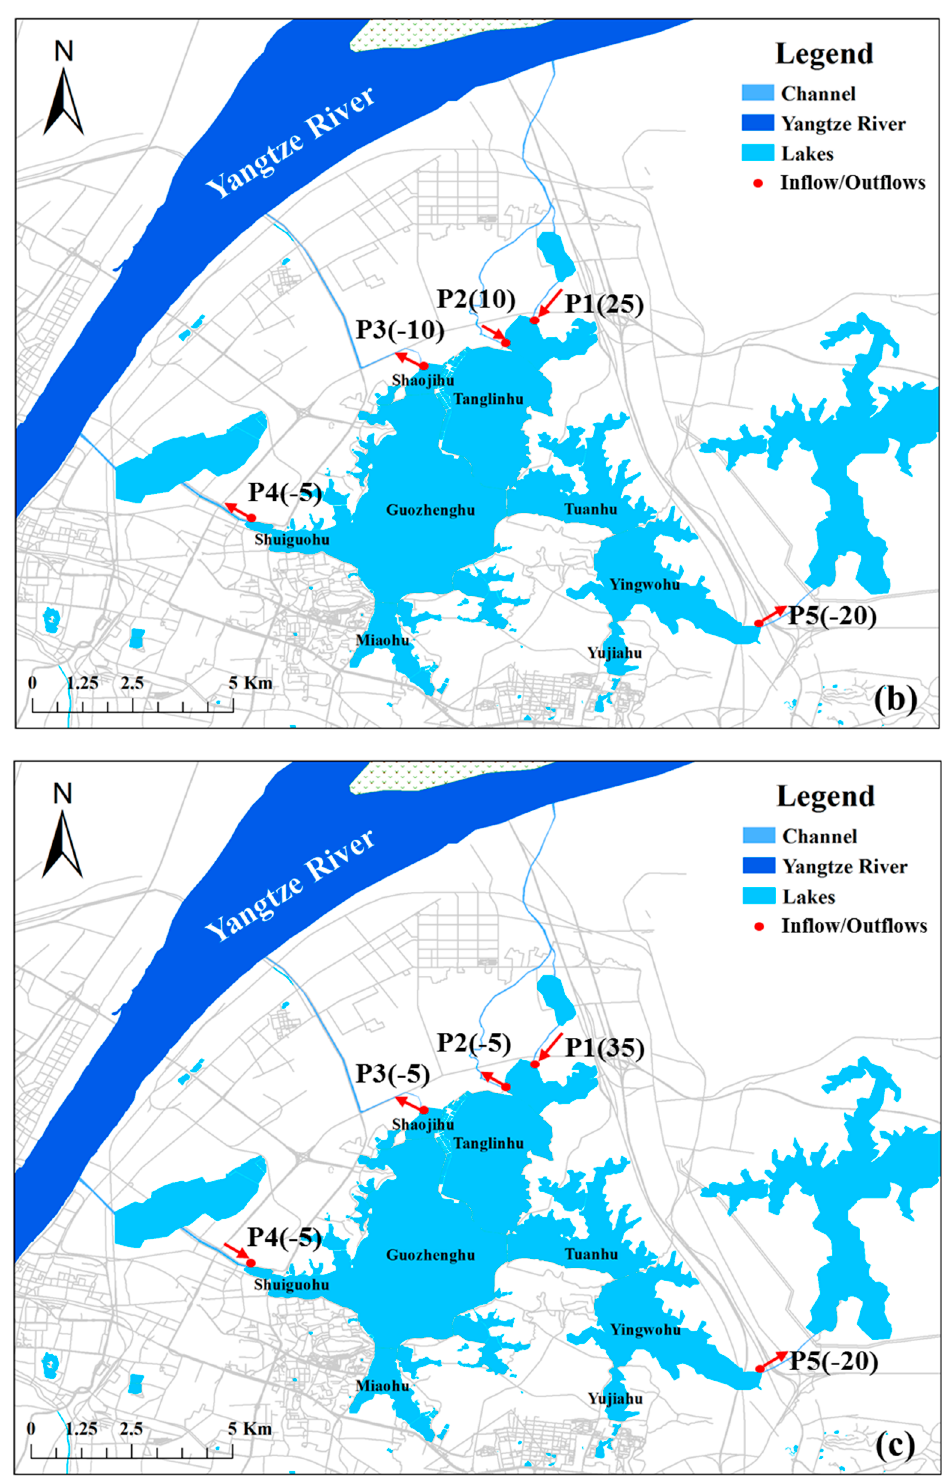
Figure 7. Water diversion scenario design: ( a ) scenario S1, ( b ) scenario S2, and ( c ) scenario S3. The values in brackets indicate discharge of inflow/outflow. The unit of the discharge is cubic meters per second. Positive values indicate inflows and negative values indicate outflows.